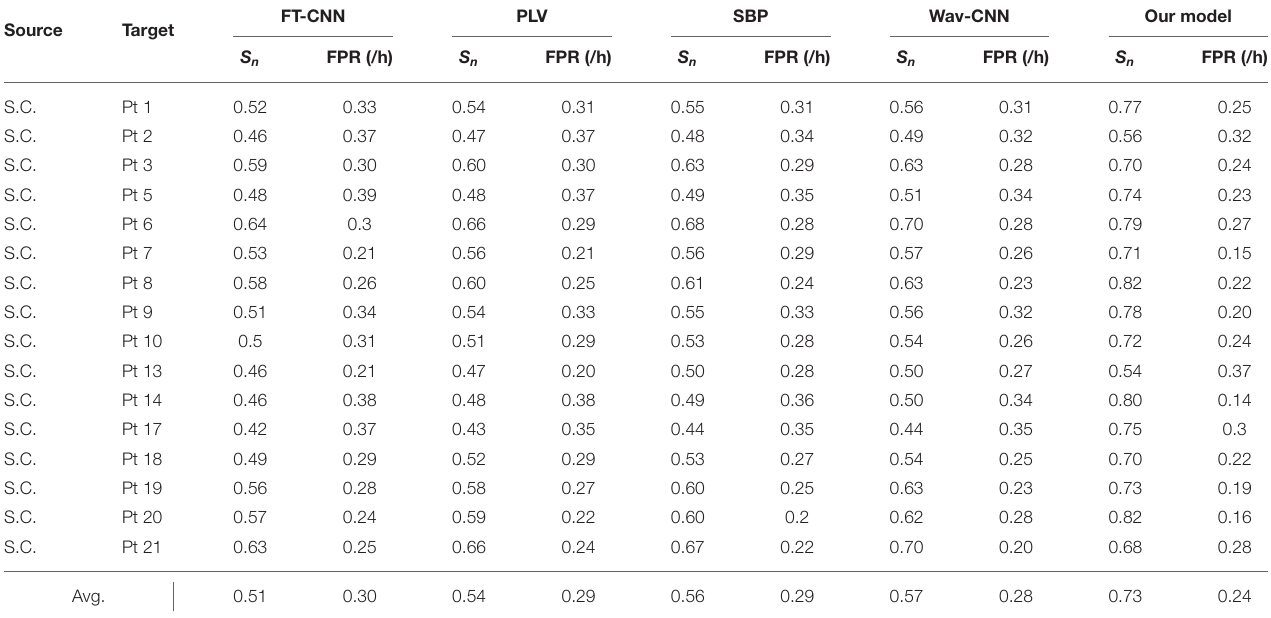
TABLE 4 | Results compared with conventional methods on the CHB-MIT database.